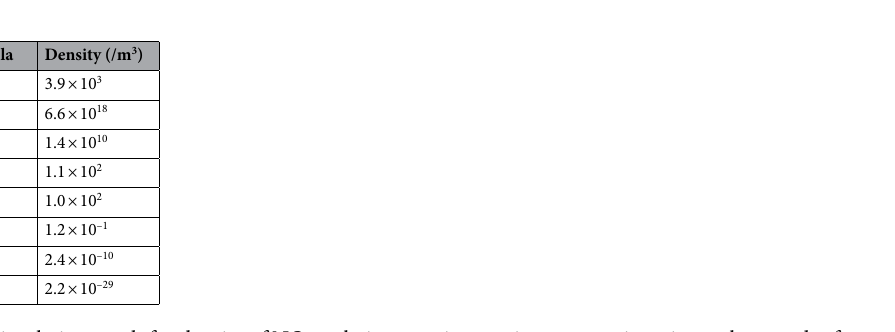
Table 1. 1D simulation result for density of NO x− relating reactive species at a certain point such as seeds after 1000